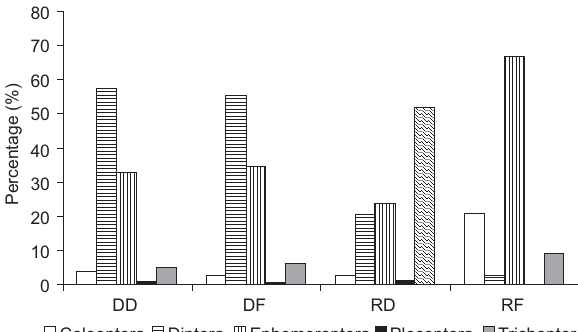
Figure 3. Relative abundance (%) of the most abundant insect or- ders sampled in leaf-bags incubated in the Ribeirão da Quinta stream. (DD) dry season-deforested area, (DF) dry season-forested area, (RD) rainy season-deforested area, (RF) rainy season-forested